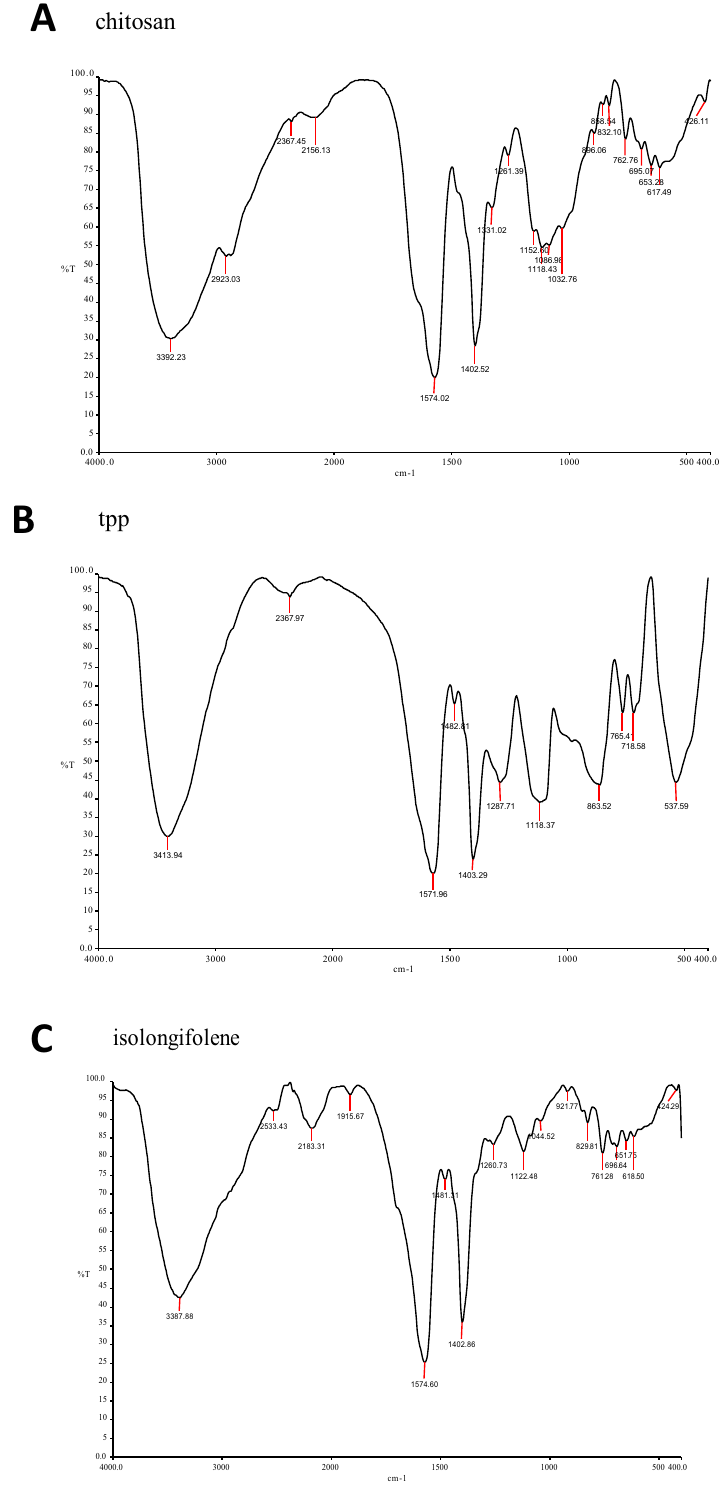
Figure 2. FT-IR spectra of Isolongifolene-Chitosan compatability. ( A , B ): FTIR spectrum of Chitosan, TPP, Isolongifolene: ( A )—stretch in 3392 cm/1 (N–H) ( B )—stretch in 1574 cm/1 (N–N). ( C , D ): FTIR spectrum of isolongifolene and cross linked isolngifolene. ( A )—1482 cm/1; ( B )—3410 cm/1 and 1482 cm/1 stretch were found. ( E , F ): FTIR spectrum of Gelatin and Glutaraldehyde. ( A )—strech in 3400 cm −1 , ( B )—stretch in 1262 cm/1. ( G ): FTIR spectrum of Gelatin isolongifolene . ( A )—Fails to possess isolongifolene Strech in 1482